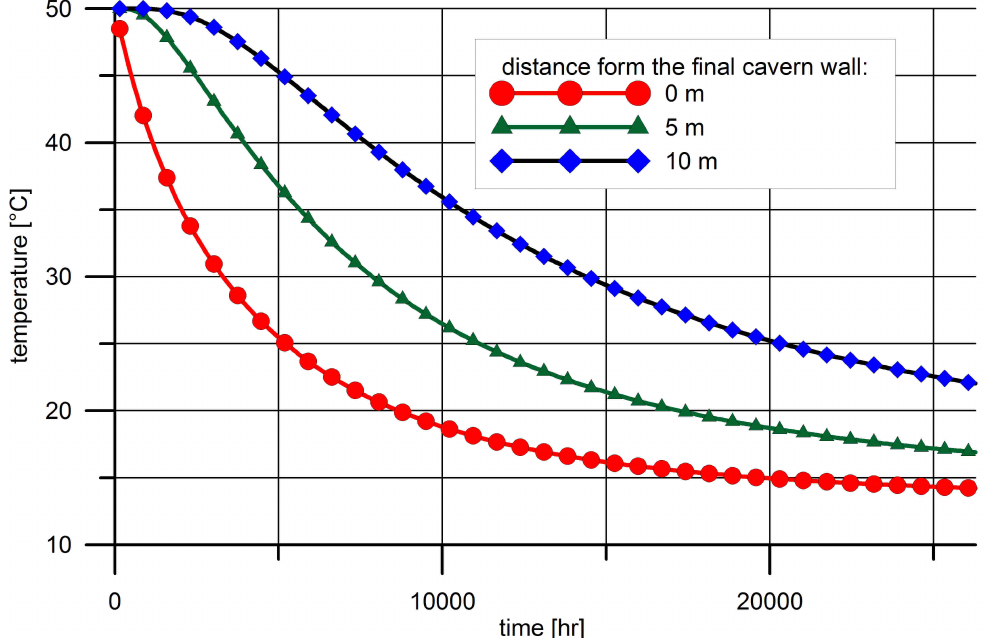
Figure 8. Temperature distribution over time on the target cavern wall and within the rock salt massif—the simplify